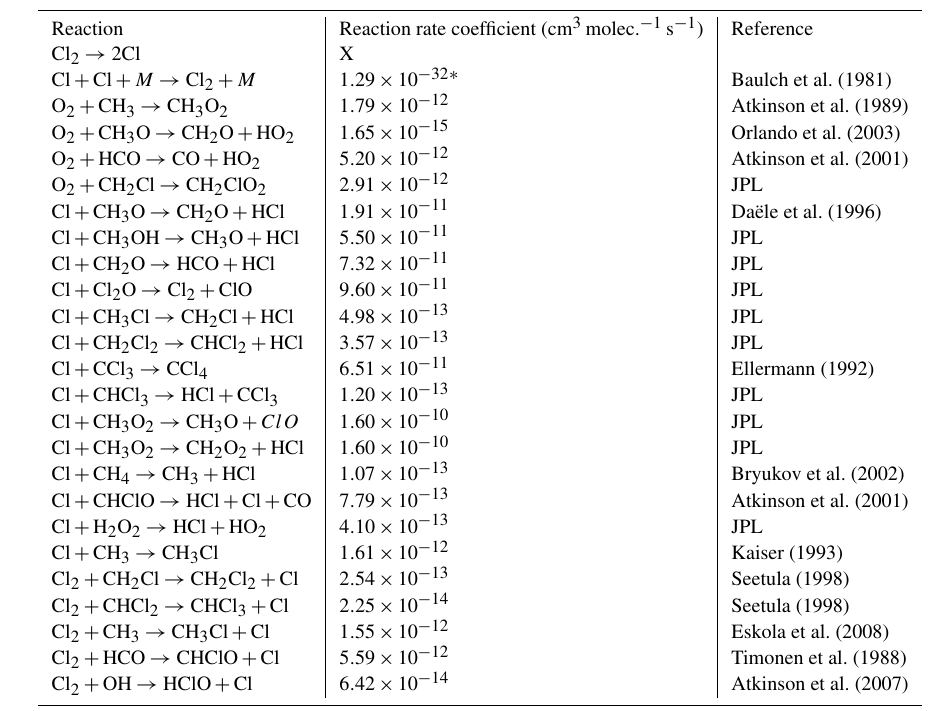
Table E1. JPL: Burkholder et al. (2020). Hossaini: Hossaini et al.